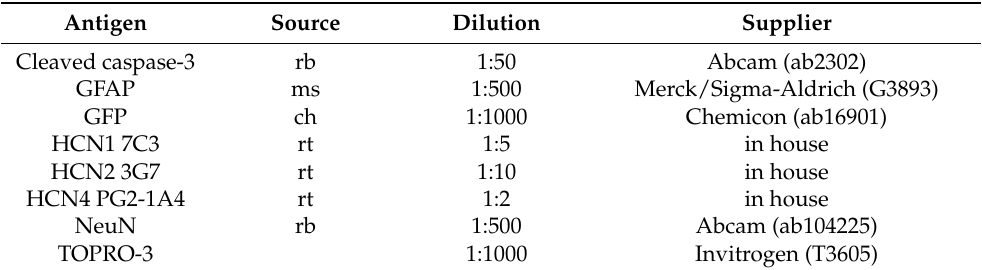
Table 3. Primary antibodies used for immunohistochemistry of tissue sections. List of primary anti- bodies applied for immunohistochemistry. Supplier: Abcam, Berlin, Germany; Merck/Sigma-Aldrich, Darmstadt, Germany; Chemicon, Merck/Sigma-Aldrich, Darmstadt, Germany; Invitrogen/Thermo Fisher Scientific, Darmstadt, Germany. Abbreviations: ch, chicken; ms, mouse; rb, rabbit; rt, rat.